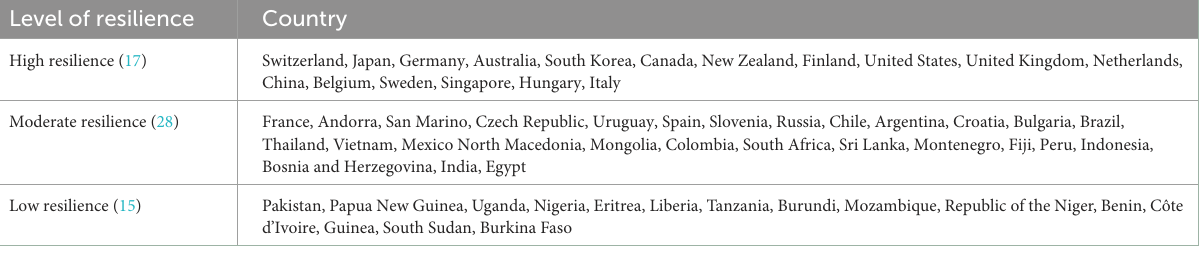
TABLE 2 Ranking of health system resilience by the clustering analysis shown in Figure 4. Level of resilience